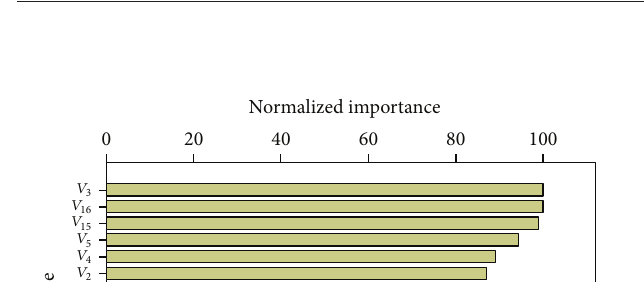
indicates the order of important variables and quantitatively describes the relationships among the occurrence of land- slides, topography, and geology. The decision-tree model